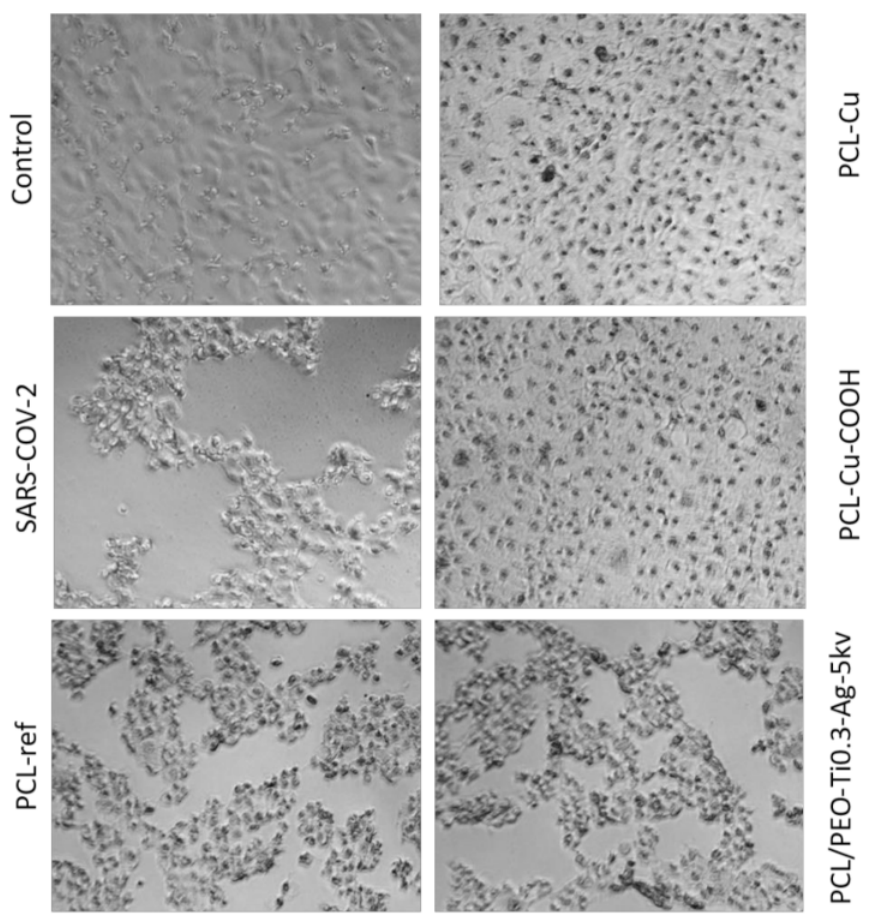
Figure 11. Optical micrographs of VeroE6 cells exposed to a virus for three days. In the presence of PCL-Cu and PCL-Cu-COOH materials, a significant protective (antiviral) effect is